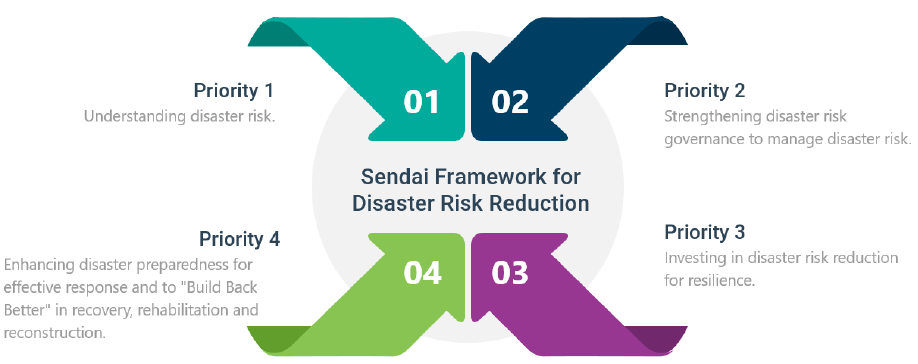
Figure 2. Sendai Framework’s priorities adopted from [21] .